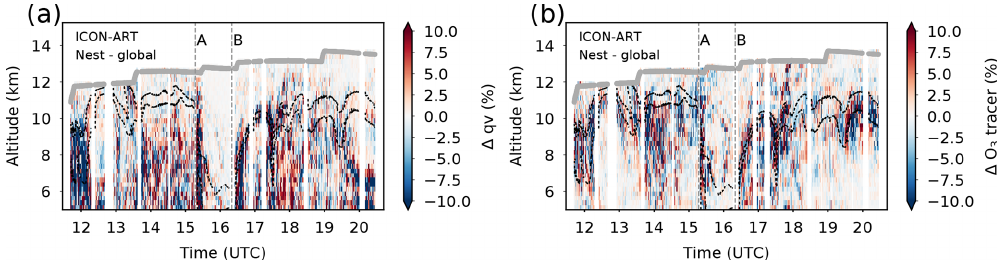
Figure 8. Residuals between the ICON-ART nested R2B7 and global R2B6 domains of q v (a) and O 3 (b) . Black lines: 2 and 4PVU isolines as indicators for the dynamical tropopause. Grey lines: HALO flight altitude.